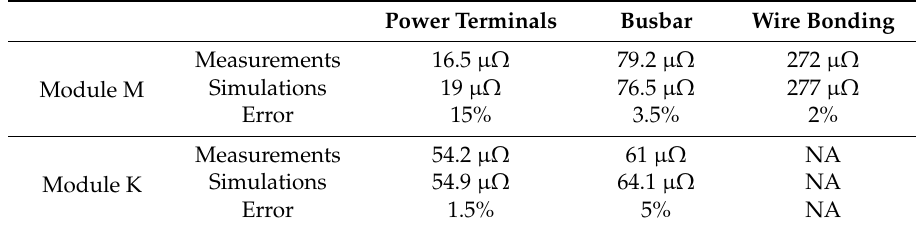
Table 3. Electrical resistance measurements and simulation. The error is defined by: (maximum value—minimum value)/(minimum